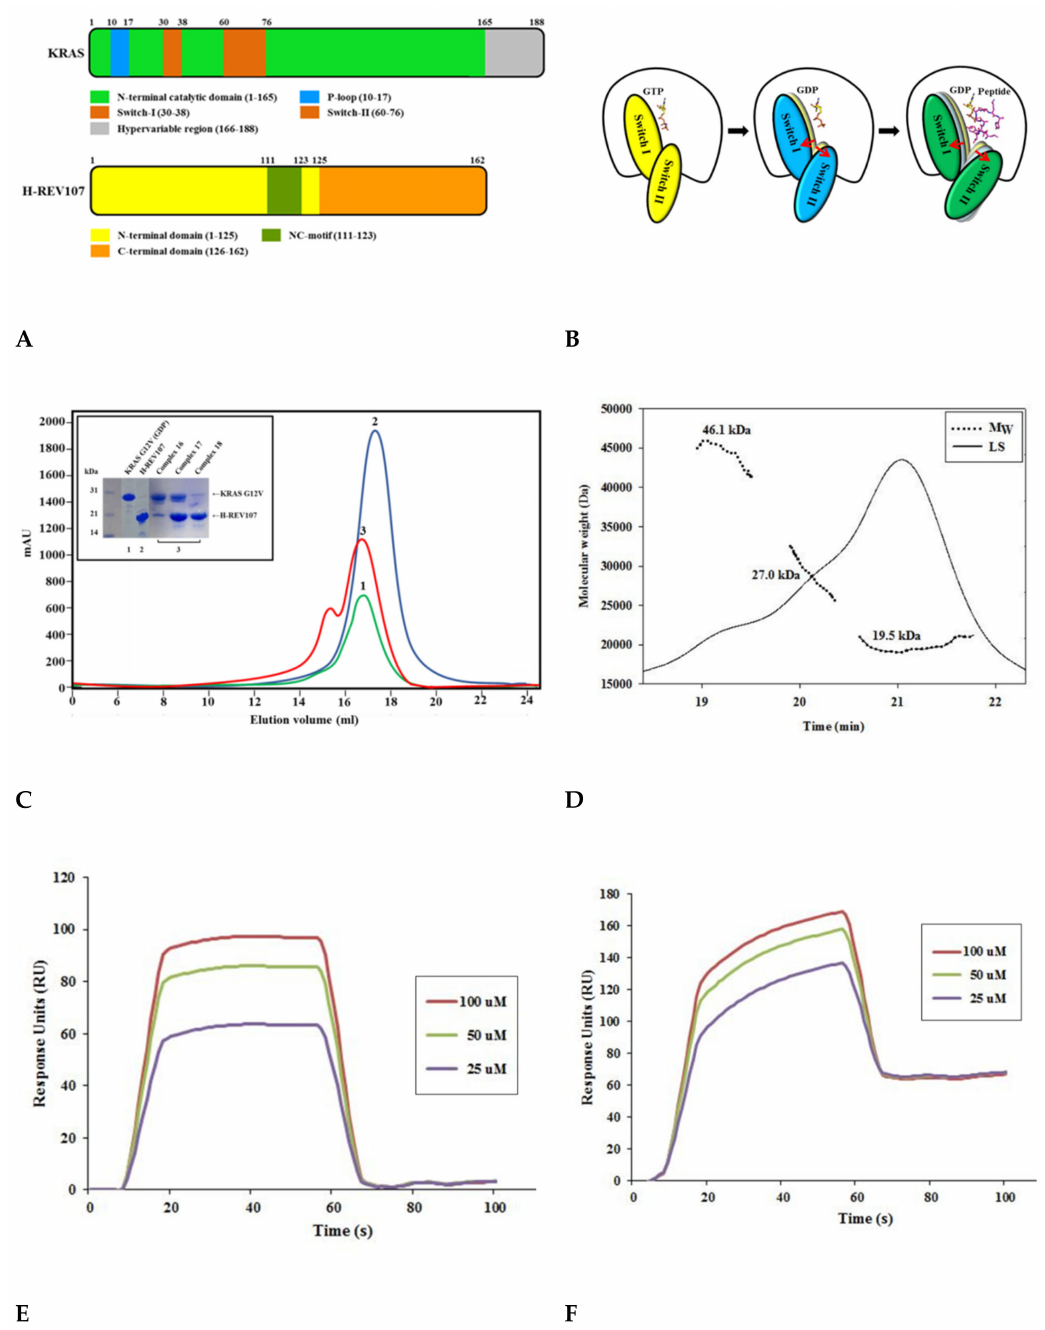
Figure 1. Schematic representation and biophysical properties of KRAS and H-REV107. ( A ) Domain structures of full-length KRAS and H-REV107 are shown. ( B ) Cartoon model of KRAS in closed (left: guanosine triphosphate (GTP)-bound), opened (middle: guanosine diphosphate (GDP)-bound), and further opened (right: GDP- and peptide-bound) forms is shown. ( C ) Size-exclusion chromatography of KRAS G12V and H-REV107 proteins. The interaction band (red) of KRAS G12V (green) with H-REV107 (blue) after application of size exclusion chromatography from the Superdex 200 column was analyzed by SDS-PAGE. ( D ) Size-exclusion chromatography–multi-angle light scattering (SEC-MALS) spectrum of the KRAS and H-REV107 complex. The inset shows the value of the molecular weight of KRAS and H-REV107 determined from the MALS data analysis (black line: MALS, dashed line: molecular weight). ( E , F ) Biacore biosensor analysis of KRAS mutant (G12V and G12D) binding to H-REV107 peptide at 25 ◦ C. H-REV107 peptide sensorgrams for 25, 50, and 100 µ M are